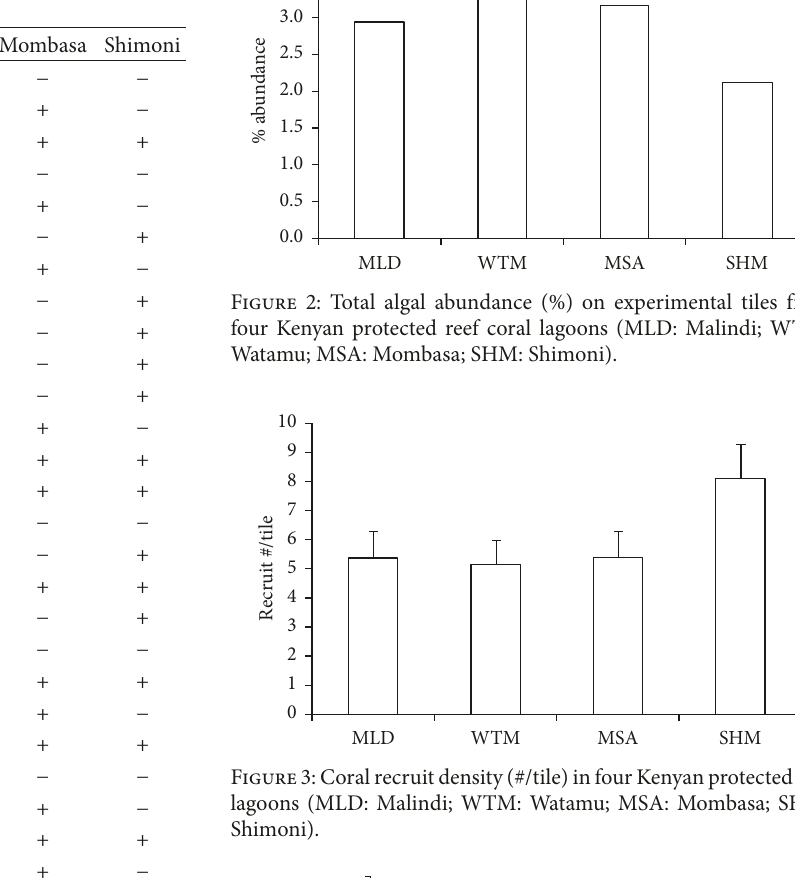
Table 2: Algal species observed on experimental tiles and their presence (+) or absence ( − ) in four Kenyan protected coral reef lagoons.